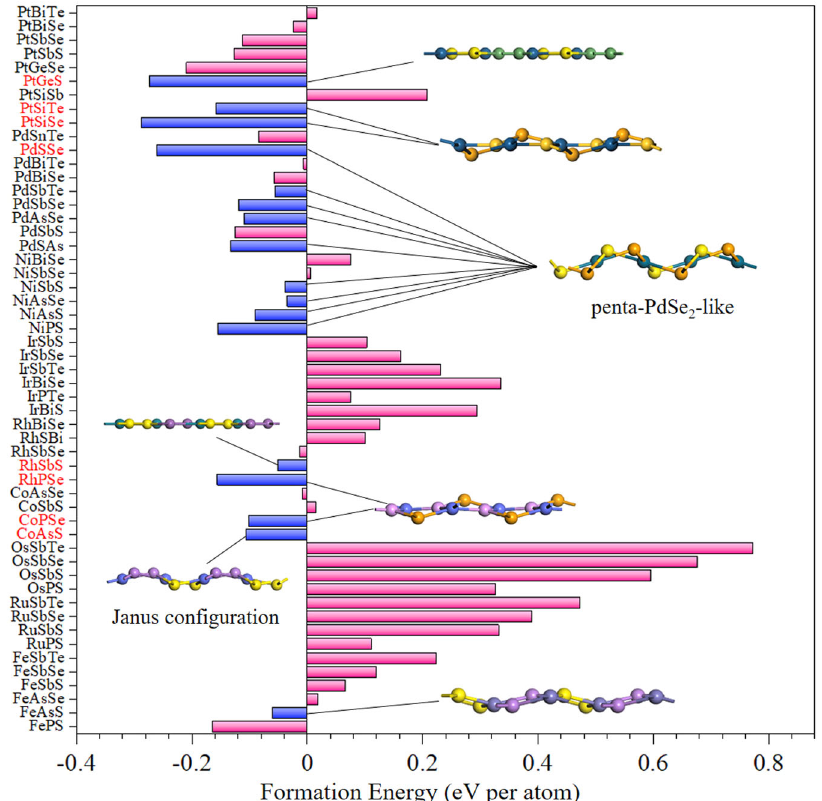
Fig. 3 Formation energy of the 53 ternary 2D pentagonal structures. The blue bars represent the 17 structures that are con fi rmed to be dynamically and mechanically stable. The compounds marked in red in the caption are semiconductors. The inset images are the side views for the stable